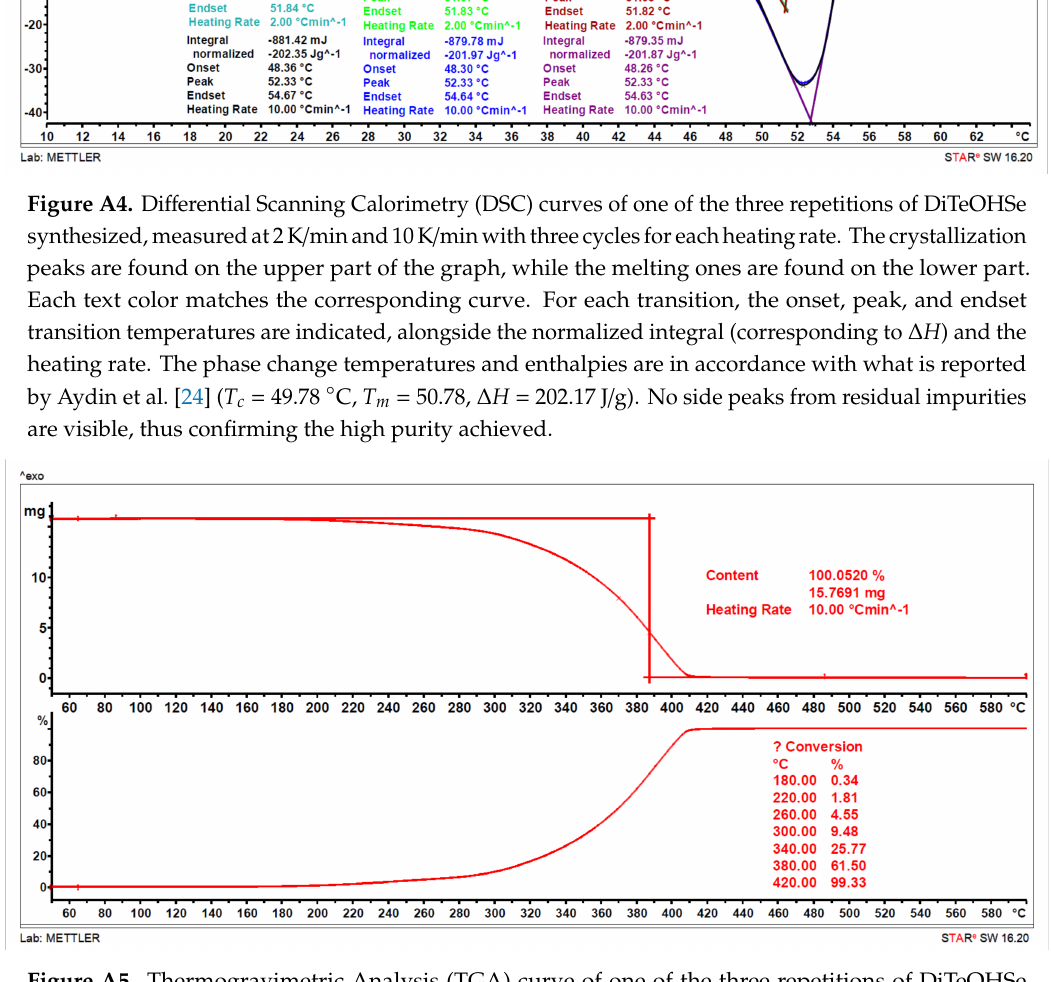
Figure A5. Thermogravimetric Analysis (TGA) curve of one of the three repetitions of DiTeOHSe synthesized. The temperature at which a mass loss equal to 5% occurs deviates with what is reported by Aydin et al. [24] ( T degradation onset = 270.07 ◦ C) of only 5–10 ◦ C. The profile of the TGA curve matches the one showed by Aydin et al.